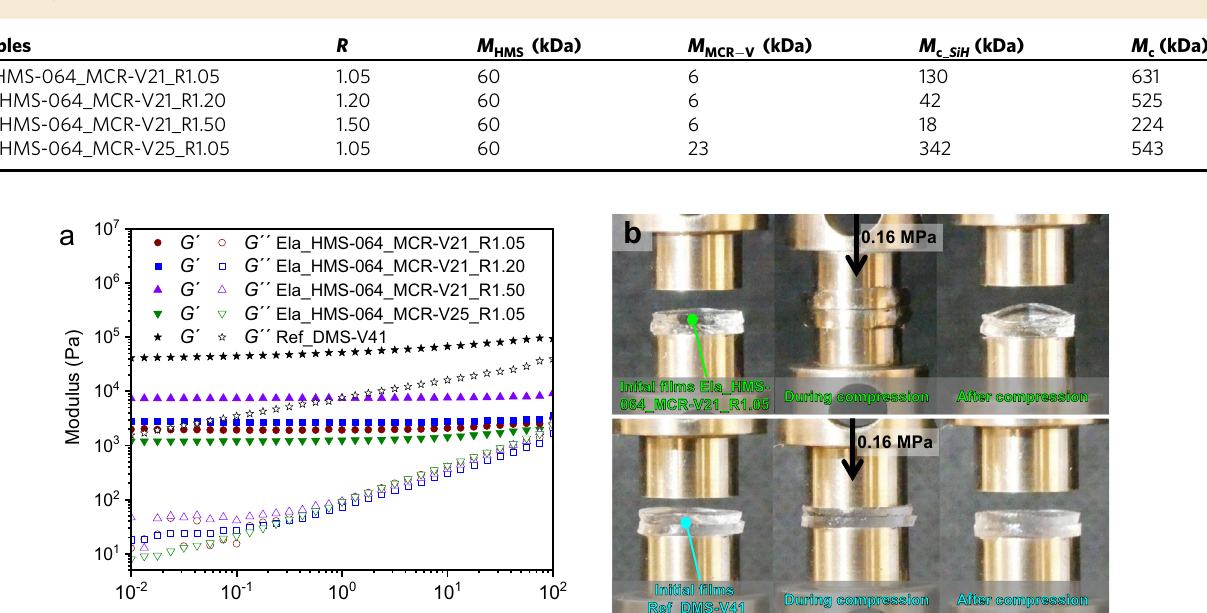
Fig. 5 Properties of extremely soft silicone elastomers and a conventional silicone elastomer. a Frequency dependence of storage and loss moduli ( G ´ and G ´´) of extremely soft silicone elastomers and a conventional silicone elastomer measured at room temperature. b Two stacked extremely soft specimens (8 mm in diameter) are compressed to a strain of 88% by a pressure of 0.16 MPa (the excess polymer is displaced up and down the sides of the geometries). After the pressure is released, the fi lms are recovered from the compressed state. In comparison, two stacked conventional specimens (8 mm in diameter) were compressed to a strain of only 19% under the same